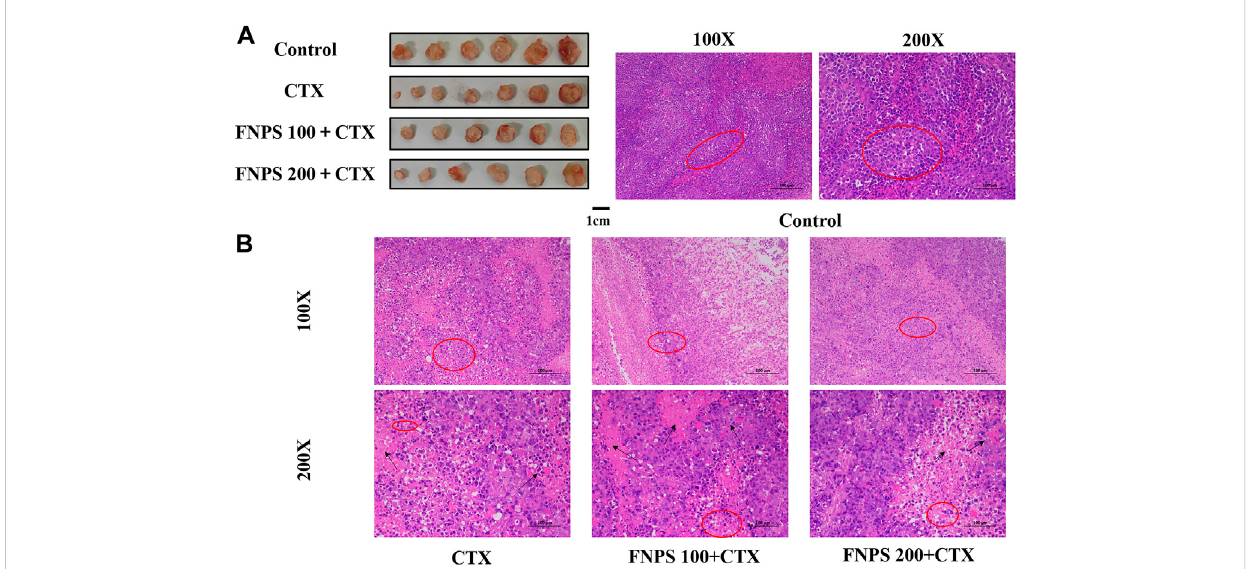
FIGURE 4 Synergistic anti-tumor effect of FNPS. (A) Representative photographs of the tumor of mice. (B) The images of H-E staining for tumor tissue. Note: Control, normal mice; Model, untreated tumor model mice; CTX, cyclophosphamide treated tumor model mice; * p < 0.05 versus Model, ** p <